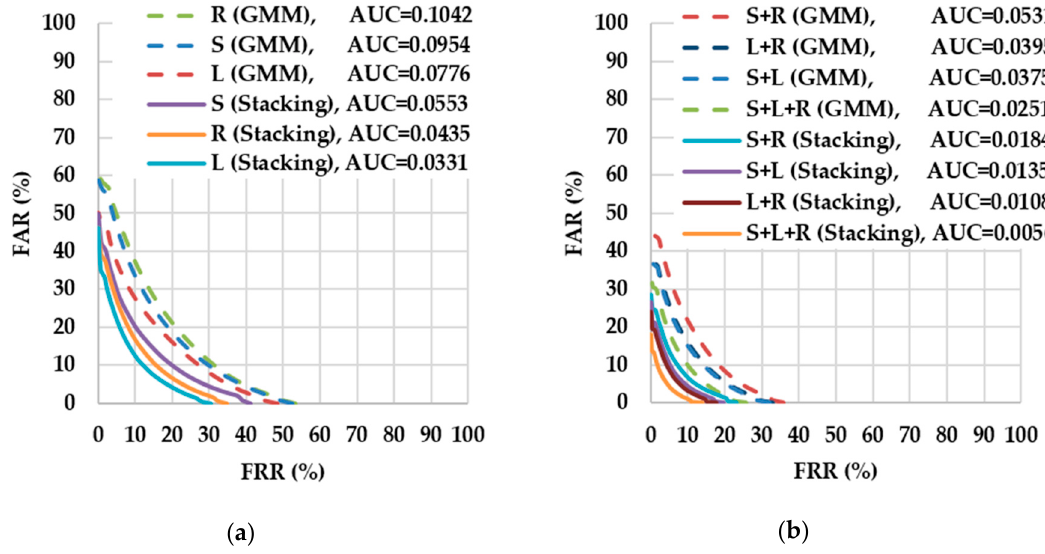
Figure 10. Detection error trade-off (DET) curves for different numbers of driving behavior models using the GMM and stacking approaches: ( a ) single driving scenario; ( b ) multiple driving scenario. Table 3. EER S for the GMM and S tacking approaches for various driving scenarios.